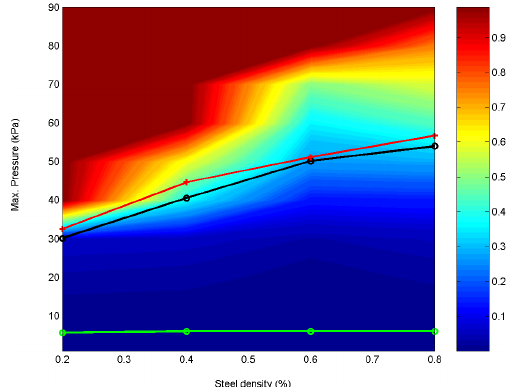
Fig. 16. Vulnerability function ( I D ) obtained for several values of steel density ( γ aB ).